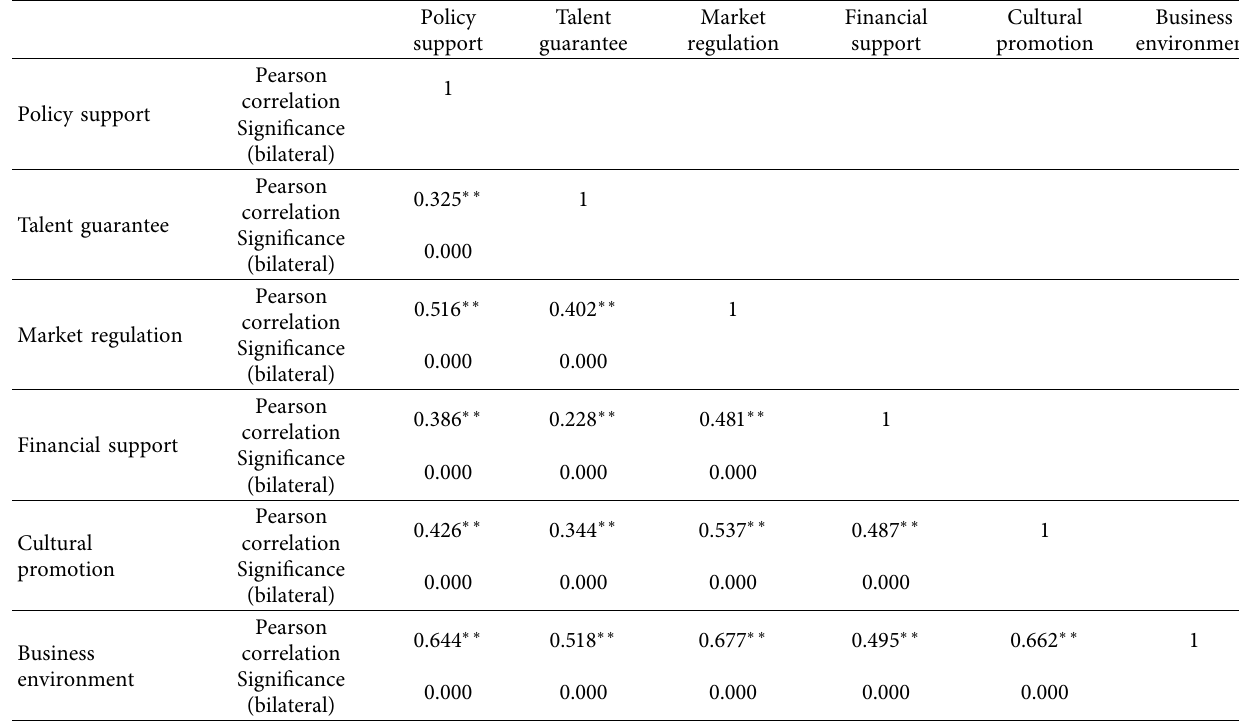
Table 6: Correlation analysis of the overall variables.